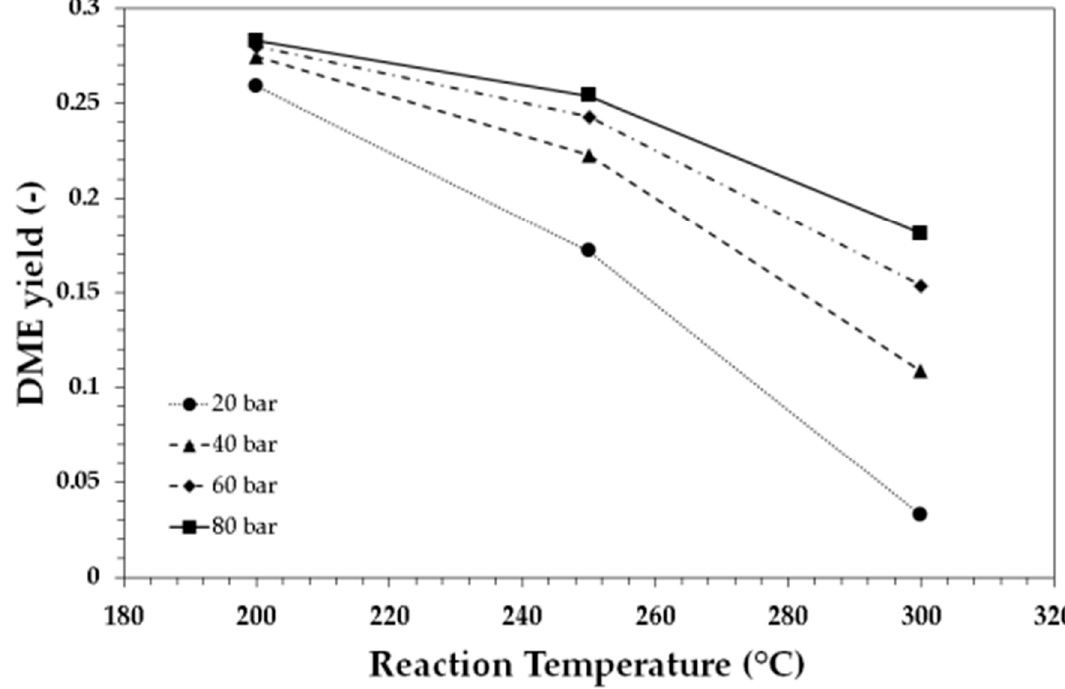
Figure 4. Theoretical equilibrium DME yield as a function of reaction temperature and pressure, for the raw syngas with the following molar composition: H 2 /CO = 0.87, CO 2 /CO = 0.94. Lines are only a guide for the reader.